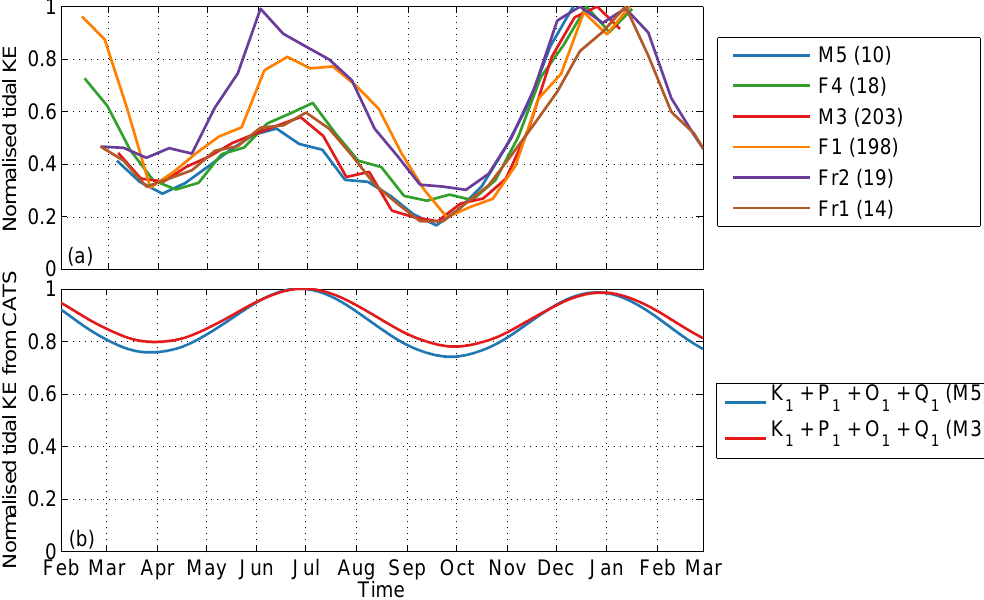
Figure 6. (a) Time series of normalised diurnal tidal KE at moorings M5 and F4 (deeper continental slope), M3 and F1 (shelf break) and the first year of record at Fr2 and Fr1 (shelf). At M5, KE is only calculated until the ADCP stops measuring (see Table 1). The maximum diurnal tidal KE values in cm 2 s − 2 are given in parentheses in the legend. (b) Time series of normalised tidal KE at the K 1 + P 1 + O 1 + Q 1 tidal frequencies as predicted by the CATS tidal model at the locations and deployment times of moorings M3 and